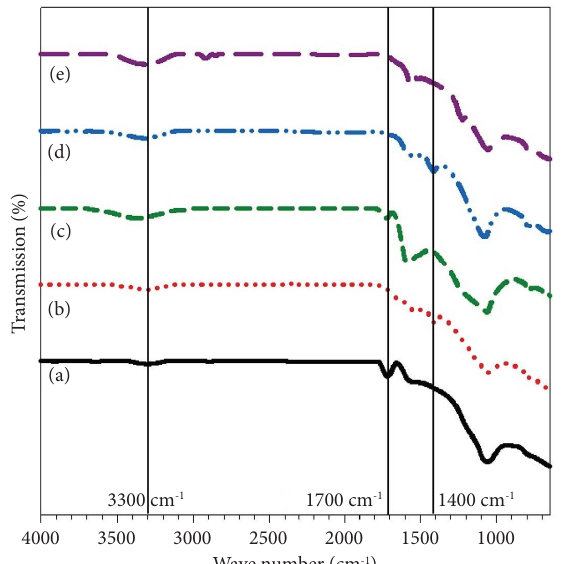
S , (c) NASH S , (d) SH R , and (e) APTES R (condition: range of